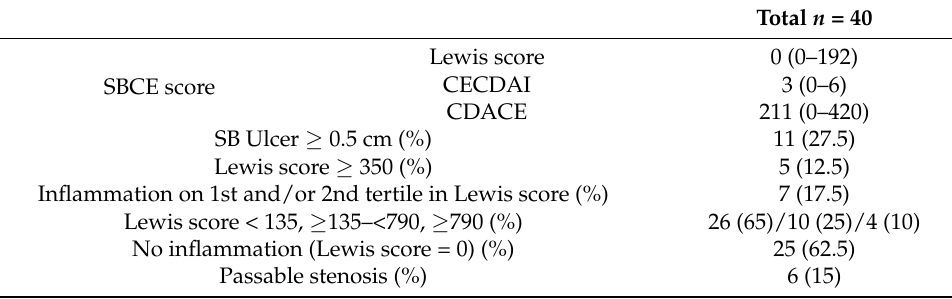
Table 2. Capsule Endoscopy score and findings.